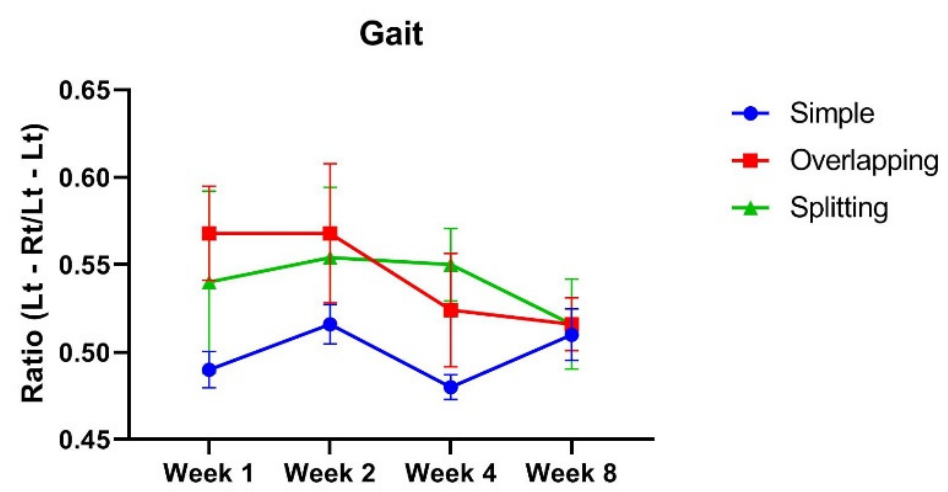
Figure 5. Gait test. The overlapping and splitting suture groups demonstrated asymmetrical gait intervals between the left and right sides through week 4. However, there was no significant difference in gait intervals between any of the groups, and the difference in gait was similar between all groups at week 8.